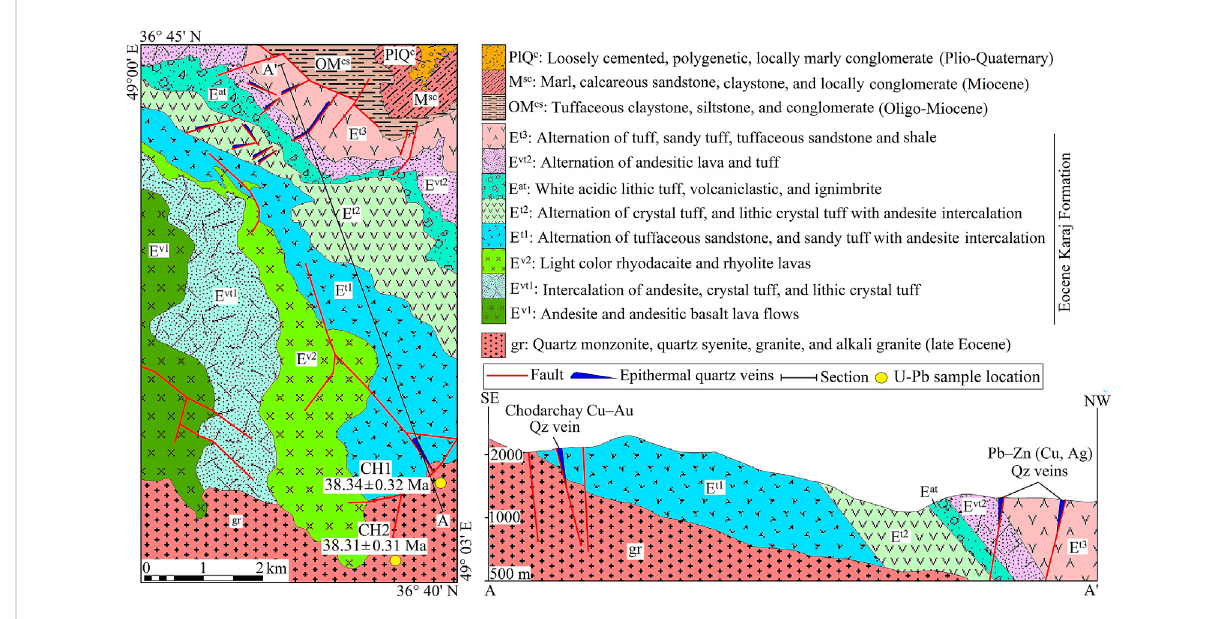
FIGURE 2 Geological map of the Tashvir Pb – Zn (Cu – Ag) deposit (modi fi ed from Kouhestani and Mokhtari,